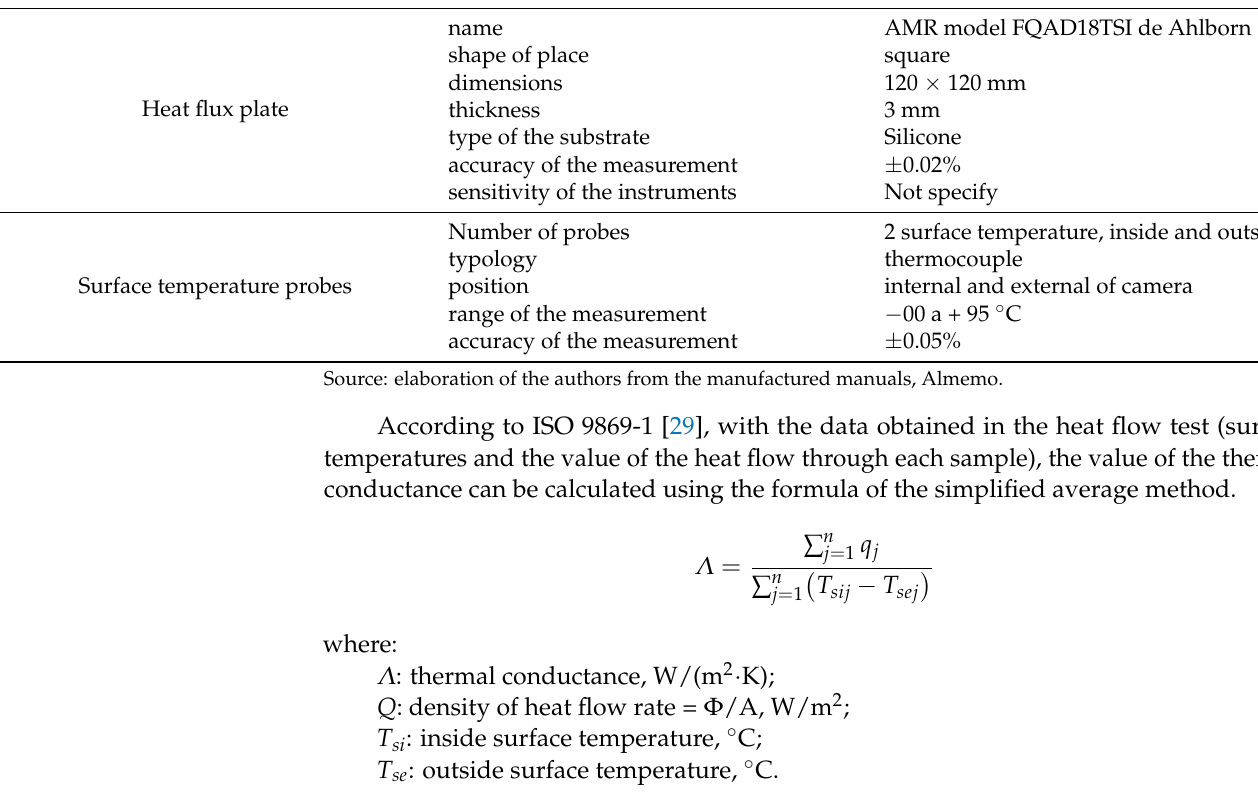
Table 1. Characteristics of HFM apparatus used.